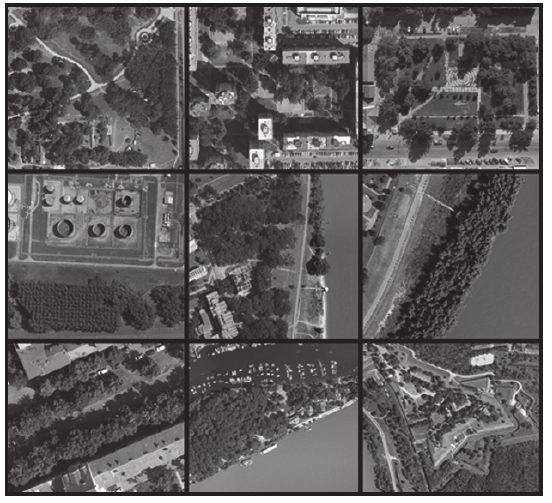
Various types of urban greenery in the City of Novi Sad, Serbia (source: